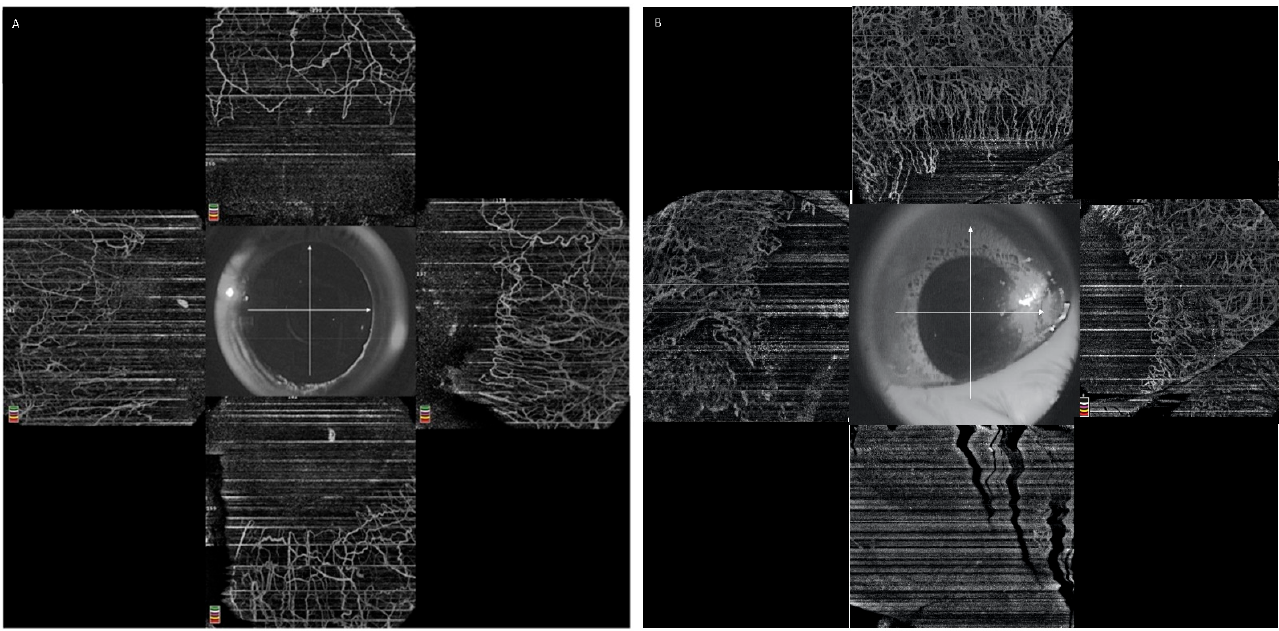
Figure 2. Collage of images depicting the role of the infrared image in anterior segment optical coherence tomography angiography (AS-OCTA) ( A ) AS-OCTA image of a normal eye with good exposure of the structures on the infrared image ( B ) Image of an eye with chemical injury showing the effect of an updrawn lower lid mimicking ischemia of the inferior limbus and sclera.